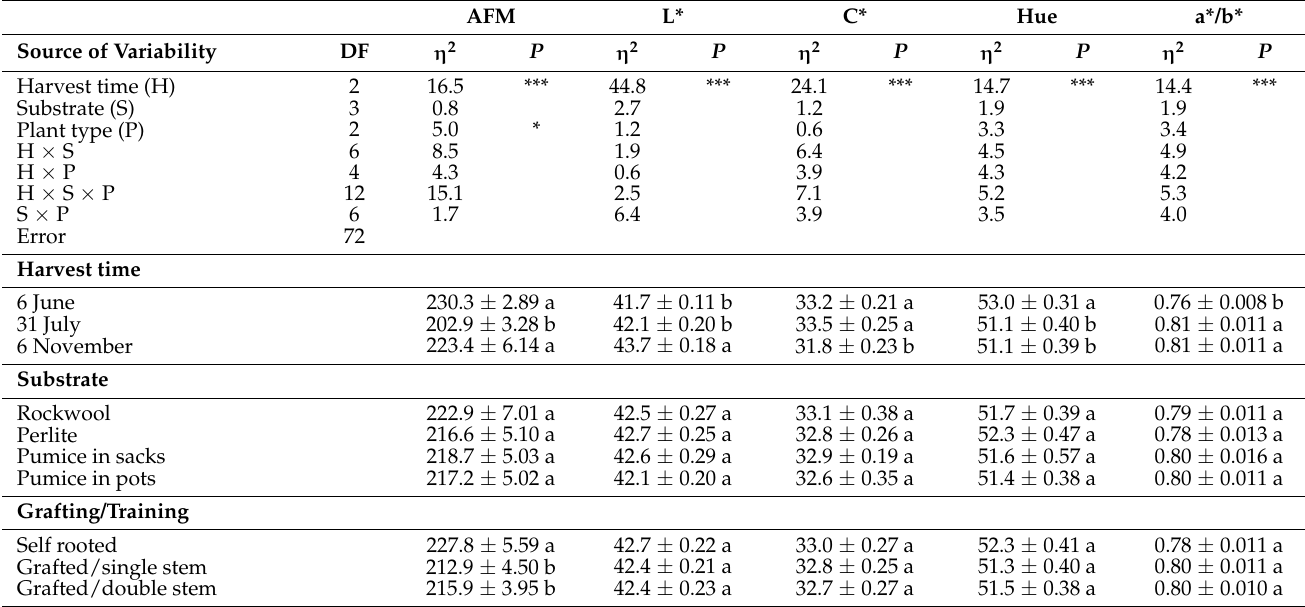
Table 1. Analysis of variance for average visual quality traits (fruit mass: AFM, luminance: L*, chroma: C*, hue, a*/b*) of tomato fruit harvested at three harvest dates (6 June, 31 July and 6 November). The fruit was obtained from self-rooted ‘Beef Bang F1’, ‘Beef Bang F1’ grafted onto ‘Defensor’, trained in single or double stem and grown hydroponically in four substrates (rockwool slabs, perlite in sacks, pumice in sacks and pumice in pots) in a